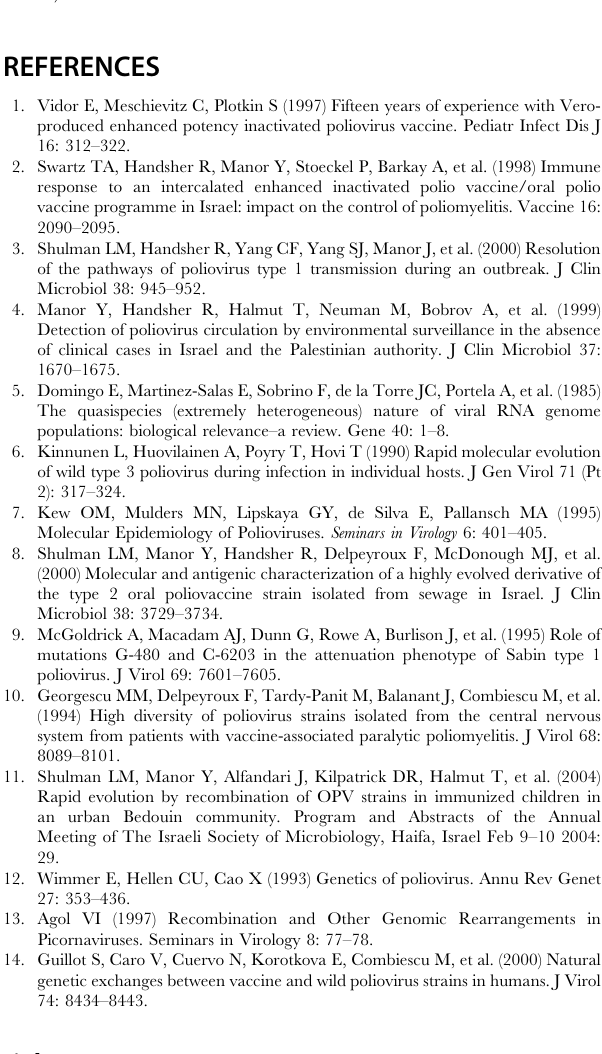
Table S1 Description of the type 2 VDPV isolated from sewage between 1998 and 2006.